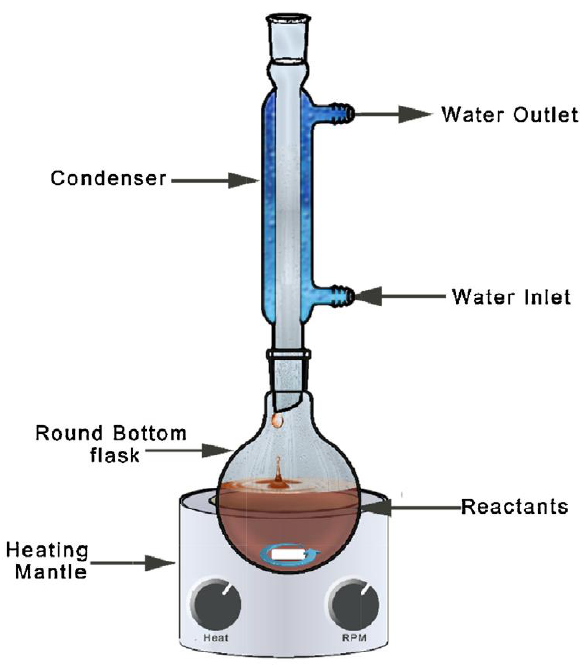
Figure 10. Schematic experimental setup of the refluxing method. Reproduced with permission from